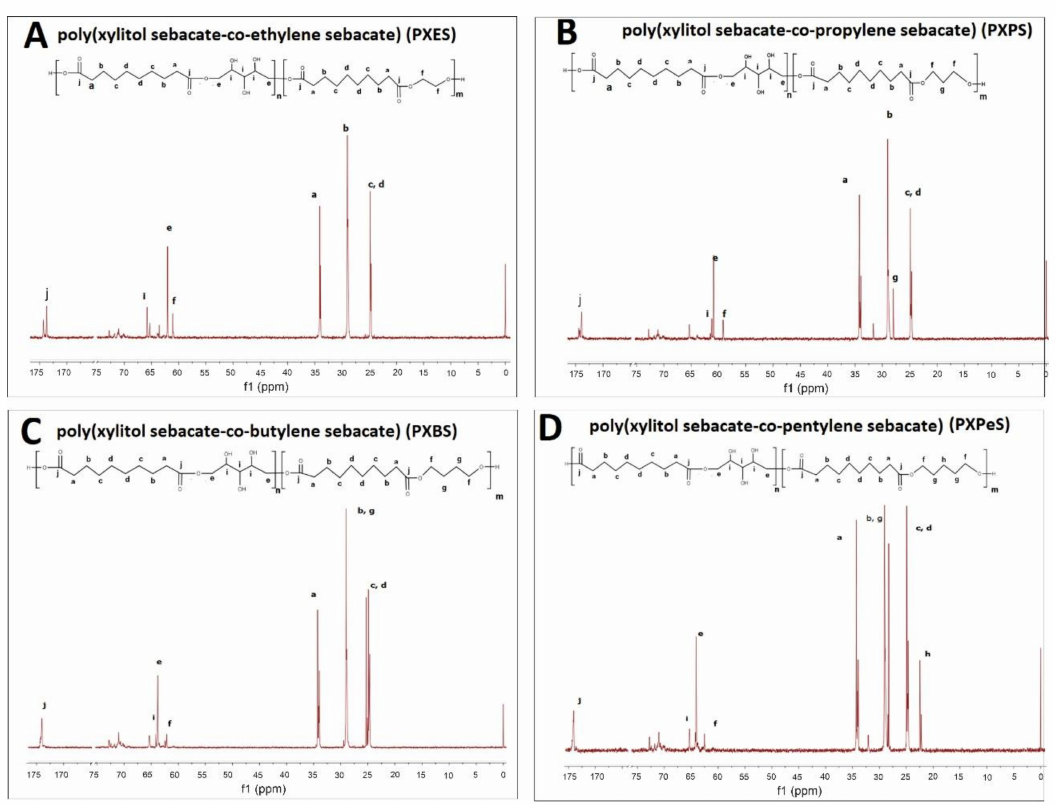
Figure 5. 13 C NMR of following prepolymers: PXES ( A ), PXPS ( B ), PXBS ( C ) PXPeS ( D )